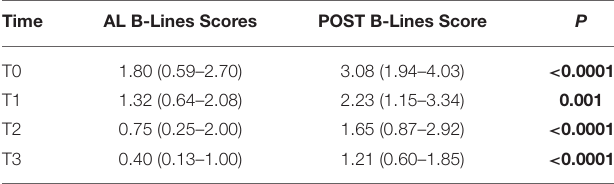
TABLE 3 | AL and POST B-lines score at each time